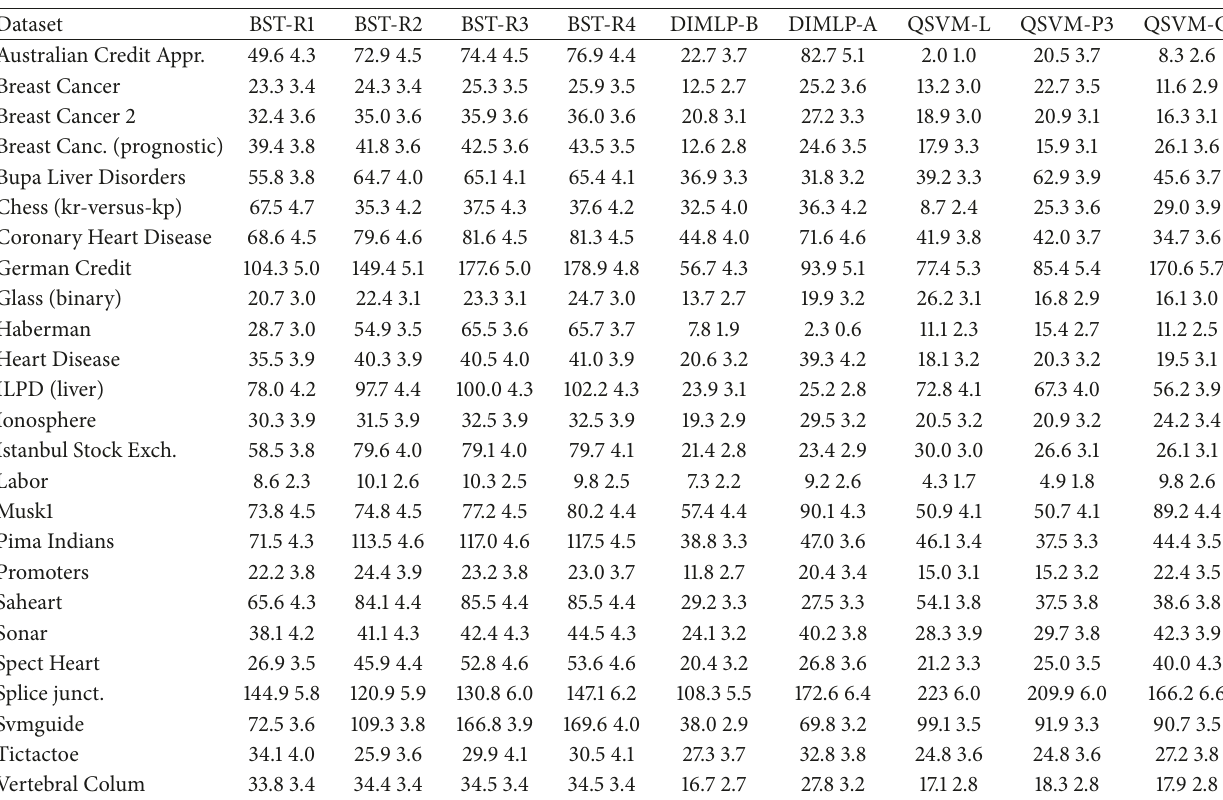
Table 7: Average complexity of the extracted rules given by the number of rules and antecedents per rule for BST-R DIMLPs and QSVMs. Dataset Australian Credit